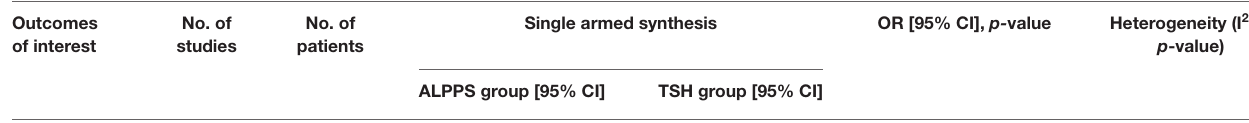
Table 3-1. Subgroup analysis of high quality studies* 90-day mortality